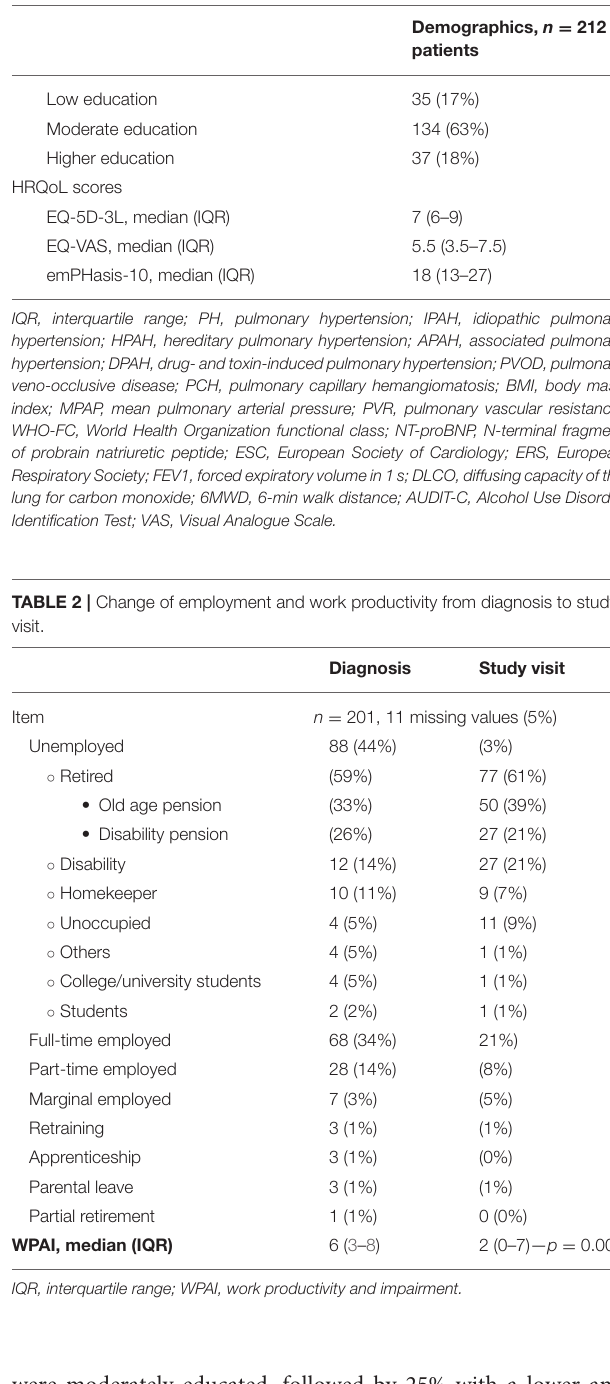
TABLE 1 | Patient characteristics at study visit.